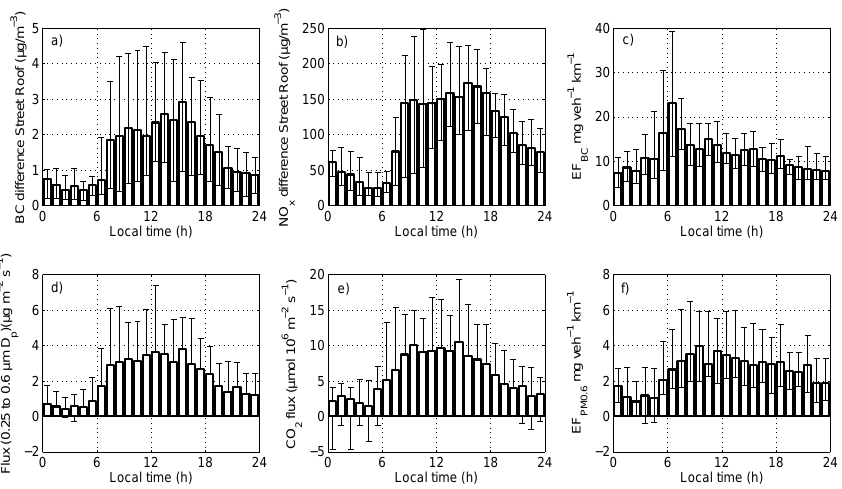
Fig. 8. Median diurnal cycles of (a) BC concentration (b) NO x concentrations (c) BC emission factor (d) particle number flux, (e) CO 2 flux, (f) mass emission factor EFRPM 0 . 6 . The vertical bars represent the 25th and 75th